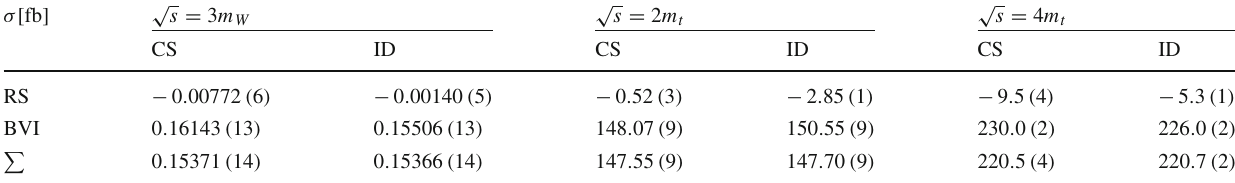
contributions (RS) were calculated using 10 7 phase-space points. The Born, virtual corrections and integrated subtraction terms (BVI) were calculated using 3 · 10 6